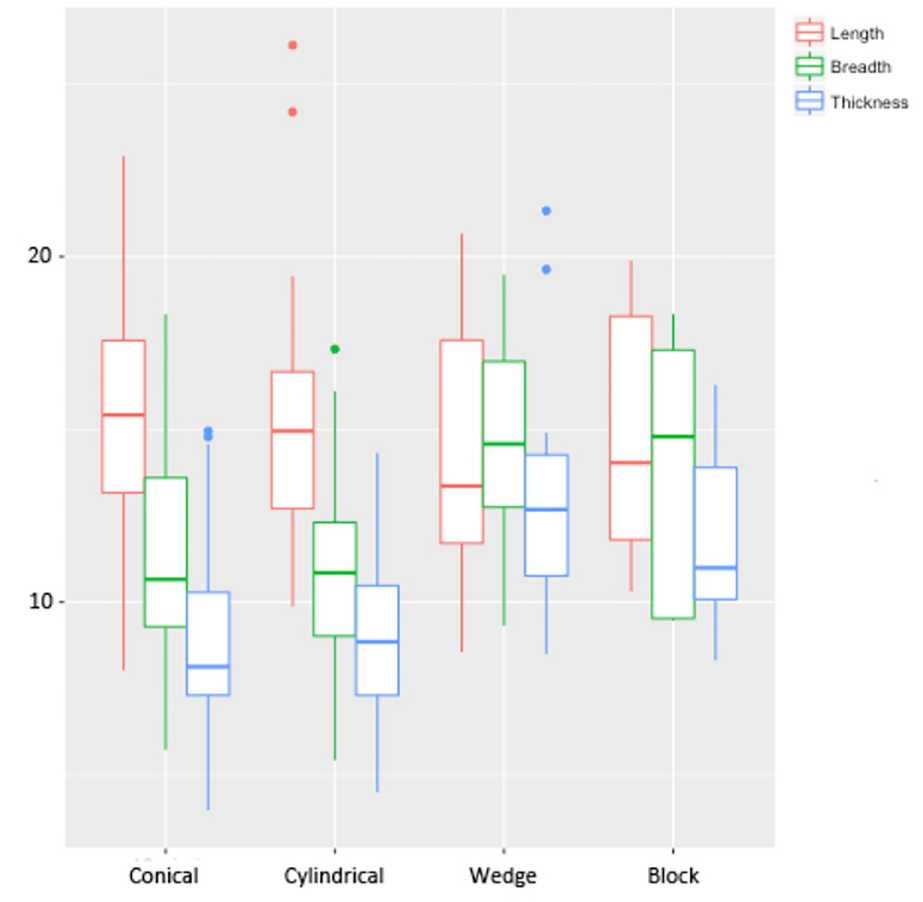
Fig 5. Boxplot showing the length, breadth and thickness (in mm) of the blade cores from Vaharvo